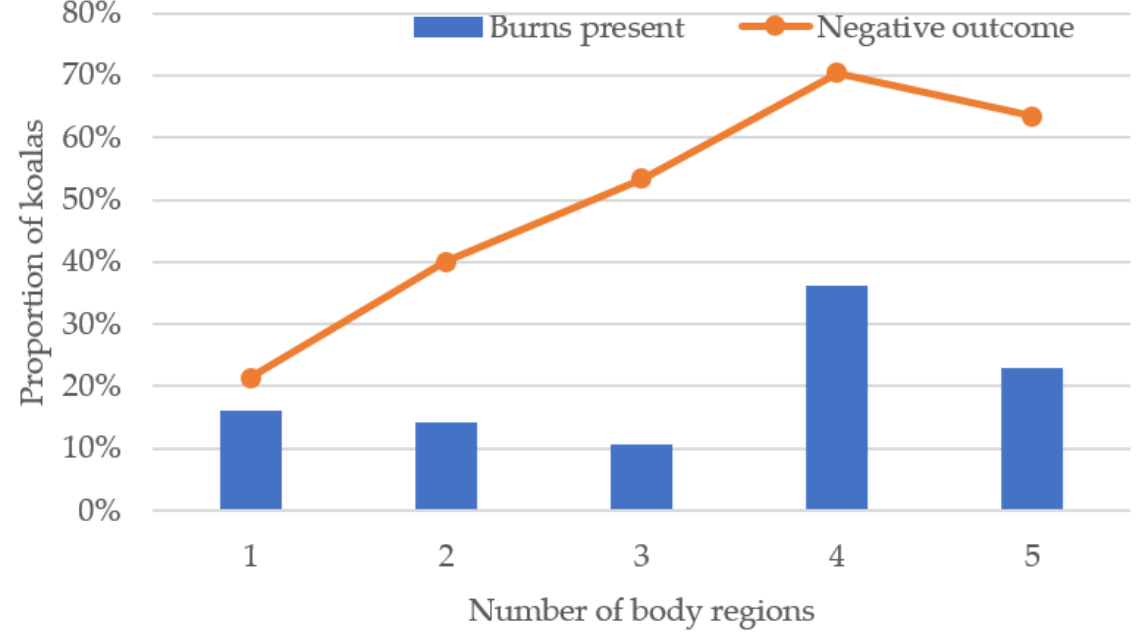
Figure 4. Proportion of koalas with burns to one, two, three, four and five regions and those with negative outcomes. The weekly proportion of koalas with burns remained relatively constant over the duration of the bushfire response (r = − 0.565, p = 0.09), although the highest weekly proportion of koalas with burns was in the first week (81.6%), and the lowest in the fourth week (42.9%). A secondary peak of a high proportion of koalas presenting with burns (73.3%) occurred in the seventh week (Figure 5).